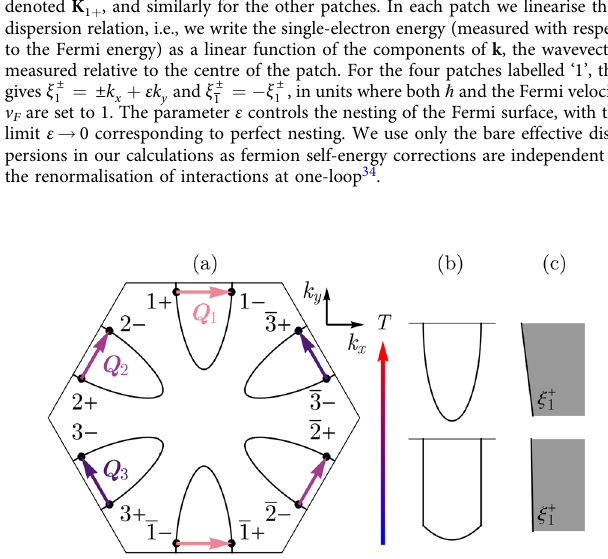
Fig. 2 Schematic Fermi surface of monolayer 1T-VSe 2 . a Schematic Fermi surface of monolayer 1T-VSe 2 with non-nested Fermi surfaces. In the low- temperature limit sections of the Fermi surface become nested. We adopt the notation of Jang et al. 25 to describe the patch scheme and nesting vectors. b Schematic change in one pocket of the Fermi surface of monolayer 1T-VSe 2 as the temperature T is lowered. c A zoomed view of the left-hand side of that pocket in our linearised